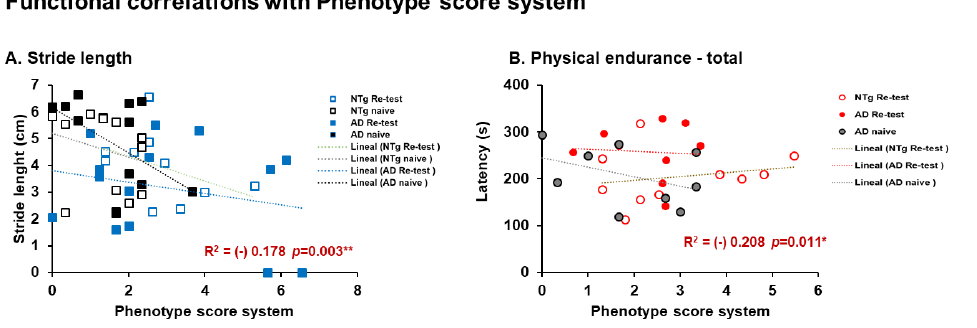
Figure 9. Functional correlations with sarcopenia index. Meaningful, Pearson ’ s correlations analysis of sarcopenia index. Meaningful, Pearson’s correlation between sarcopenia index quadriceps and